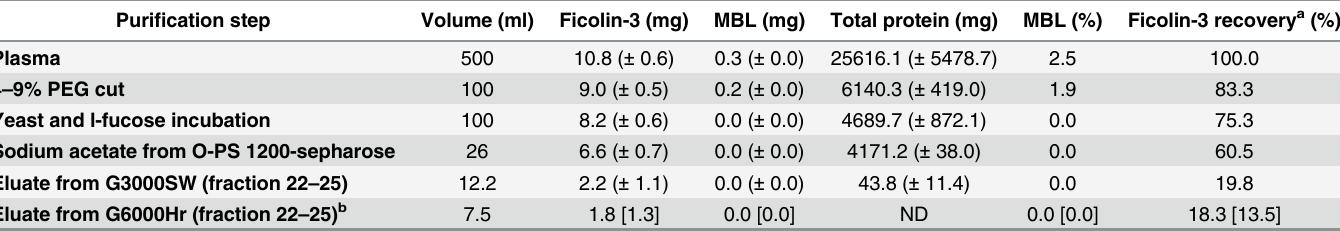
Table 1. Ficolin-3 Complexes Recovery and MBL and Total Protein Concentration During the Purification